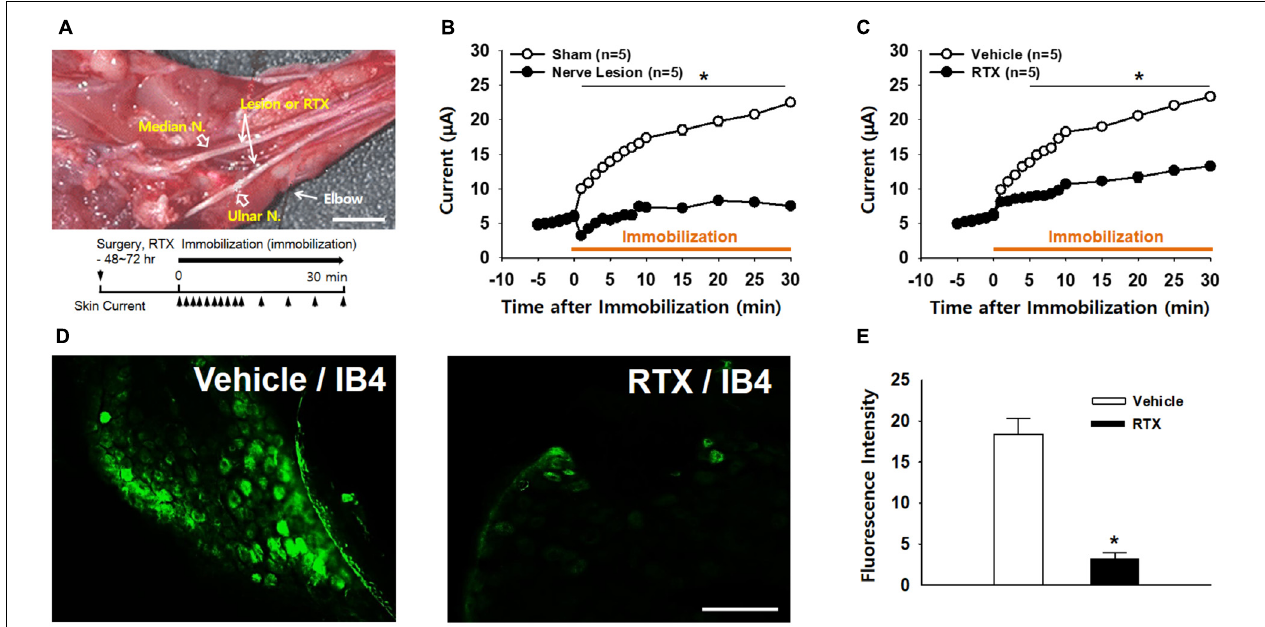
FIGURE 4 | Blockade of high conductance at acupoints by either surgical nerve injury or perineural injection of RTX in IMH rats. (A) A photograph of the median and ulnar nerves at the plane of the elbow segment. Arrows indicate sites for surgical lesions or perineural injection of resiniferatoxin (RTX). Bar = 20 mm. (B) Effect of surgical nerve injury on the development of high conductance at acupoints in IMH rats. Peripheral nerve injuries abolished the development of high conductance at acupoints, compared to leaving the nerve intact (sham). ∗ p < 0.05. (C) Effect of perineural injection of RTX on electrical skin conductance in IMH rats. (D,E) Epifluorescent images showing IB4-labeled neurons in the C8 DRG of a rat injected with IB4 into RTX- (RTX/IB4) and vehicle-treated (vehicle/IB4) ulnar nerves. An FITC IB4 tracer was bilaterally administered into nerves of rats 48 h after perineural injection of either RTX or vehicle into ulnar nerves. Significantly fewer IB4-labeled cells were found in the RTX-treated DRGs ( n = 10 slices from three animals) than in those treated with vehicle ( n = 10 slices from three animals, Vehicle). ∗ p < 0.001 vs. vehicle. Bar = 100 µ